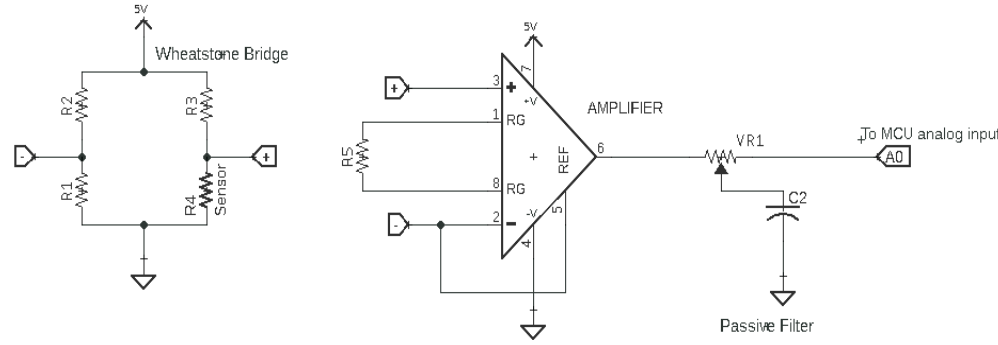
Figure 5. Schematic diagram of a Wheatstone circuit.